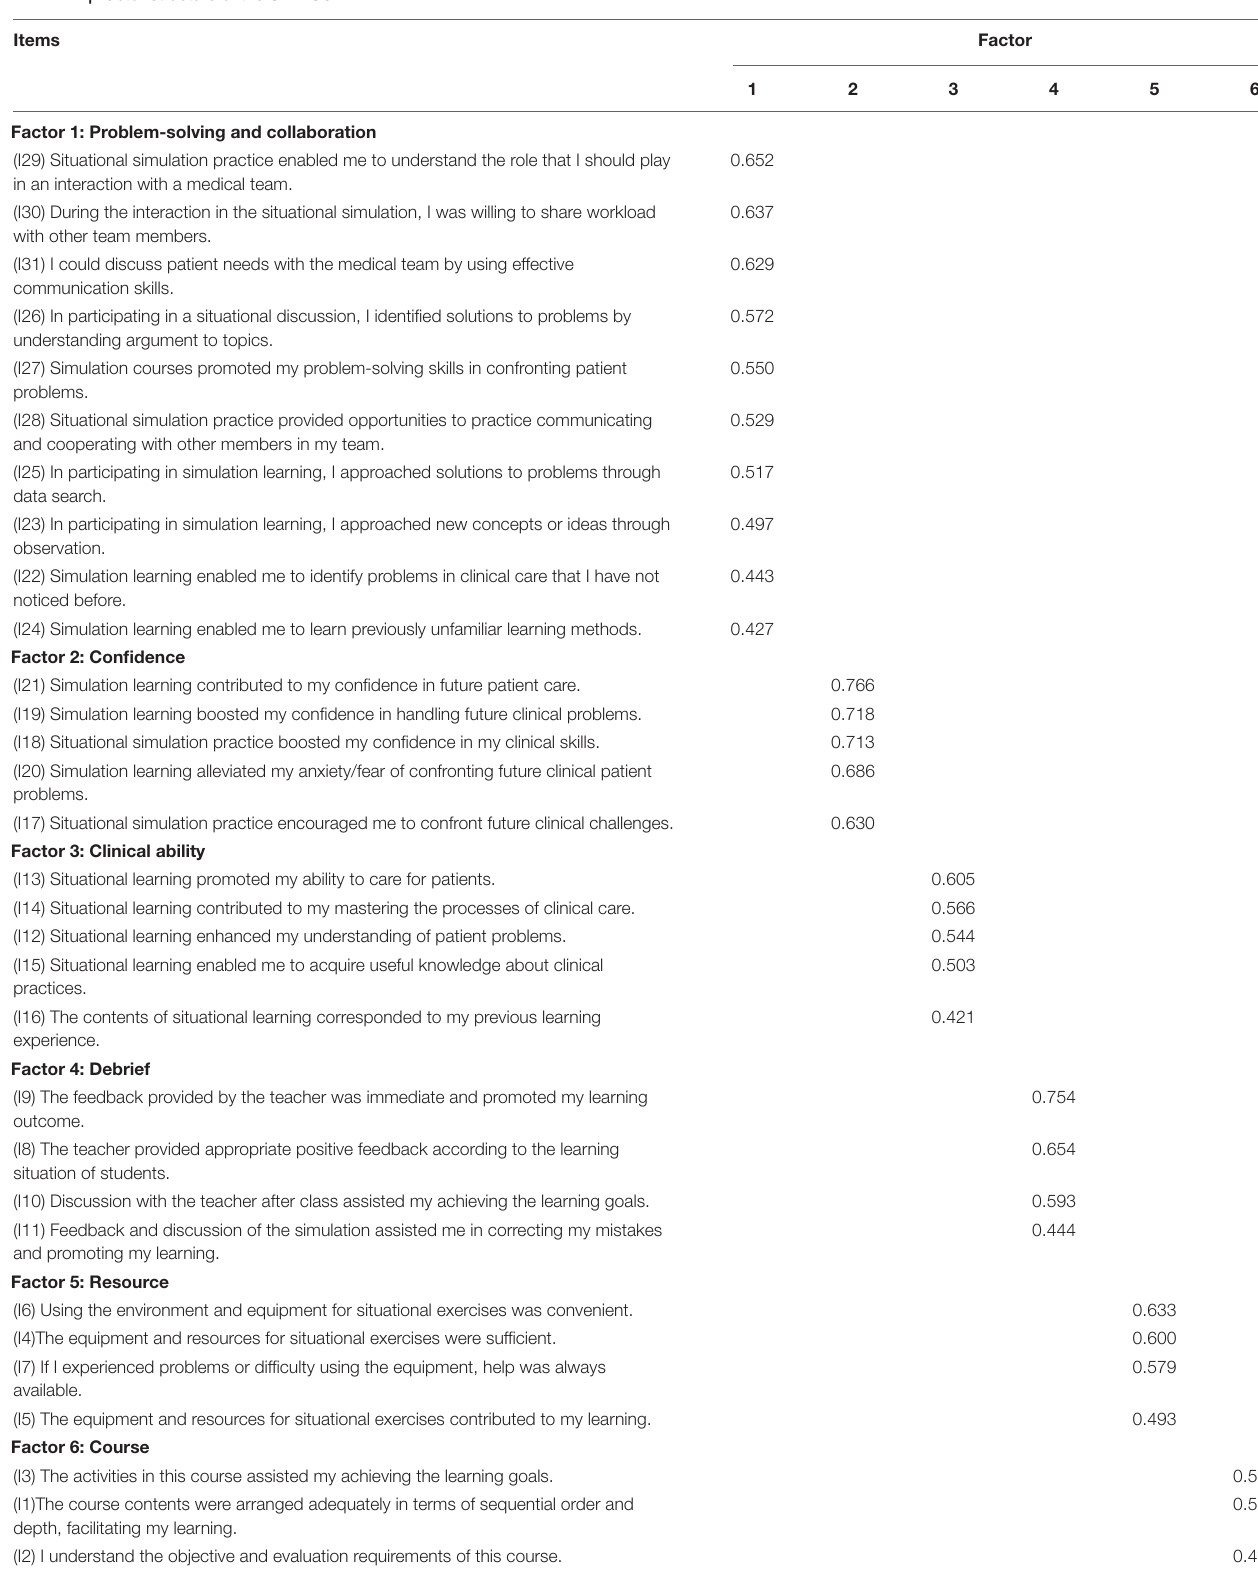
TABLE 1 | Factor structure of the SLEI-SC.